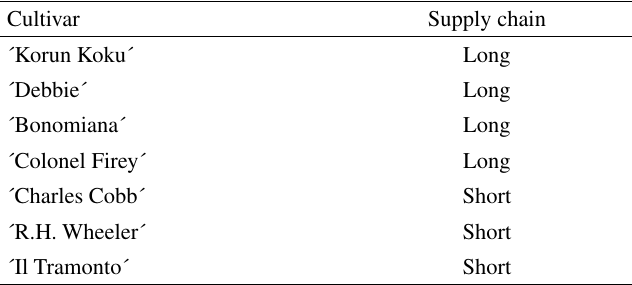
Table 1 - The studied Camellia japonica cultivars and their supply